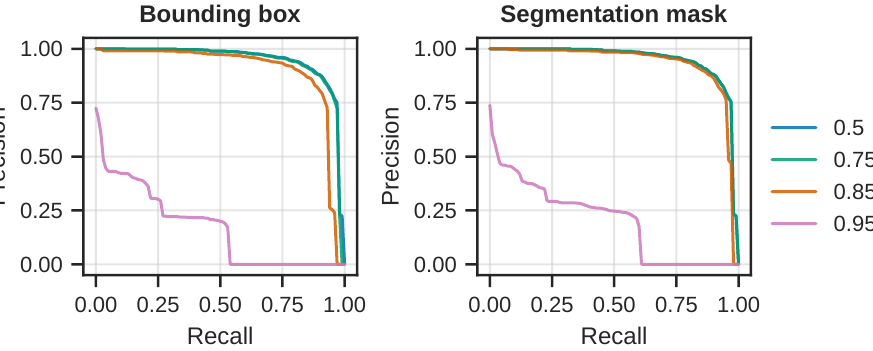
Figure 10. The average PR curves without the “sediment” class, at different IoU thresholds for both tasks. ( Left ): Without the “sediment” class, the curves for thresholds { 0.5,0.75,0.85 } are almost identical, whereas there is still a major decrease for the 0.95 IoU threshold. ( Right ): The PR curves for the segmentation task paint the same picture as for the detection task, indicating that few predictions are correct above 0.95 IoU, and that very many targets are not being